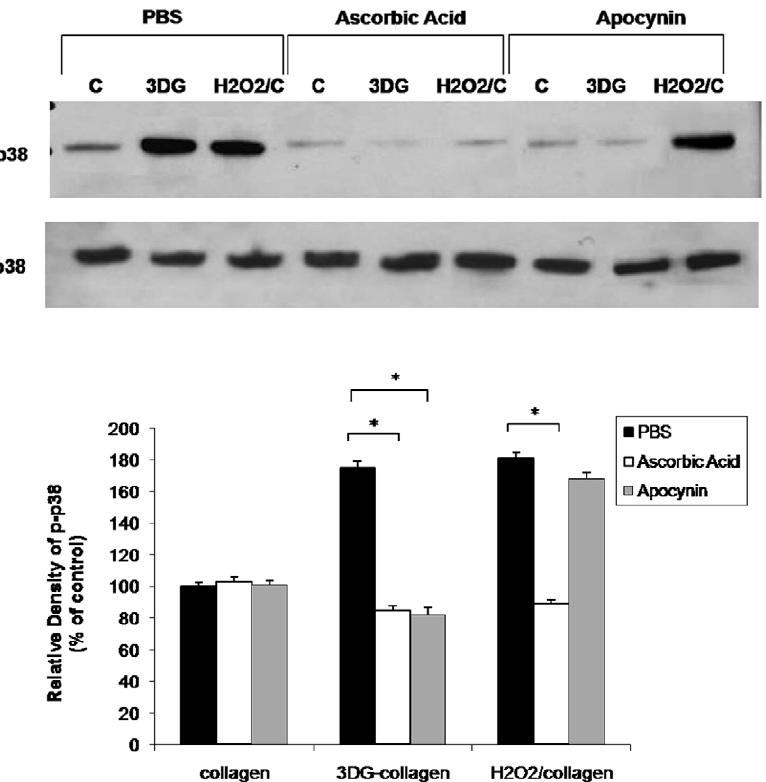
Figure 5. Phosphorylation of p38 MAPK is dependent on 3DG-collagen-induced ROS. Fibroblasts were pretreated for 1 h with 100 m g/mL of ascorbic acid, 1 mM apocynin, or DMSO and cultured on either native collagen, 1 mM 3DG-collagen, or treated with 50 m M H 2 O 2 for 24 h. Whole cell lysates were extracted and Western blot analysis of p-p38 MAPK was performed. Total p38 MAPK was used as a loading control. The bars correspond to the densitometric value of p-p38 MAP kinase after normalization for total p38 MAP kinase. Data are mean 6 SD (n=3), *P , 0.0001.